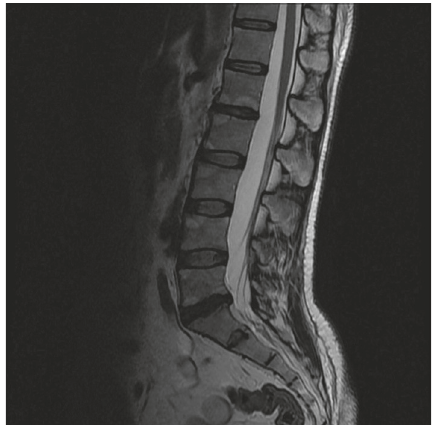
Figure 7: T2 sagittal MRI scan of the lumbar spine revealing Modic type 2 degeneration.